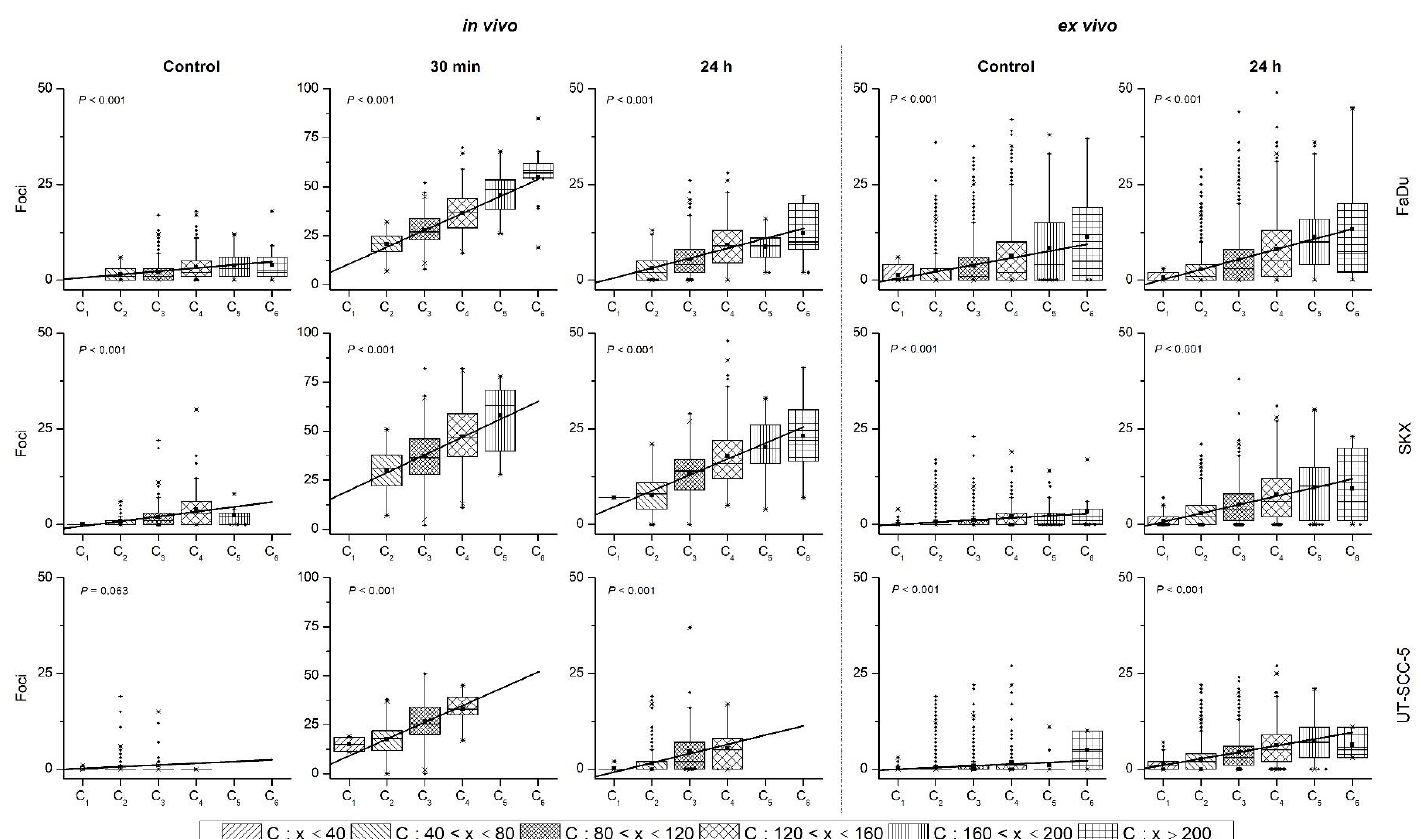
Figure 2. Number of foci linearly increases with the nucleus area (x i ) categories (C). Exemplary box plots of foci number as a function of the nucleus area categories in FaDu ( upper row ), SKX ( middle row ), and UT-SCC-5 ( lower row ) of control (0 Gy) and exposed (4 Gy) tumors. Nucleus areas were classified into six categories with an interval size of 40 µm 2 . Foci number of controls and exposed tumors, which were fixed 30 min and 24 h post exposure for the in vivo set-up ( left panels ) as well as controls and exposed tumor fixed at 24 h post exposure for the ex vivo set-up ( right panels ) are shown. P value of the linear regression analysis is shown. The linear regression analysis outputs as well as data for the remaining six hHNSCC models are presented in supplementary Figure S1 and Table S4. Please note the different Y-axis for 30 min post-exposure in the in vivo set-up.